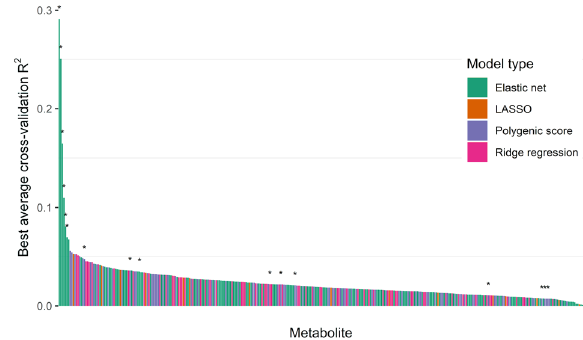
Fig. 2 Metabolite prediction model performance. The prediction performance of the best model for each metabolite is shown arranged in order of decreasing R 2 . Metabolites with a signi fi cant locus from the genome-wide association study (GWAS) meta-analysis are denoted with an